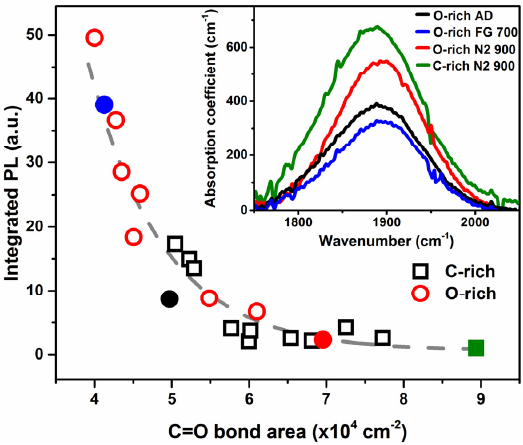
Figure 2. I PL of both compositions of SiC x O y thin films and nanowires (NWs) related to the carbonyl bond area from the infrared absorption spectra. It was observed that the I PL of the films dropped in an exponential fashion with respect to the carbonyl bond area present in the material by ~50 times. Gray dashed line is a guide-to-eye. Solid blue, black, and red points correspond to the O-rich FG 700 °C, as-deposited, and N 2 900 °C samples respectively. Solid green square corresponds to the C-rich N 2 900 °C sample. Inset: Infrared absorption spectra depicting the modulation of the carbonyl bonding present in the as-deposited, FG 700 °C, and N 2 900 °C passivated O-rich samples, as well as the N 2 900 °C passivated C-rich sample.